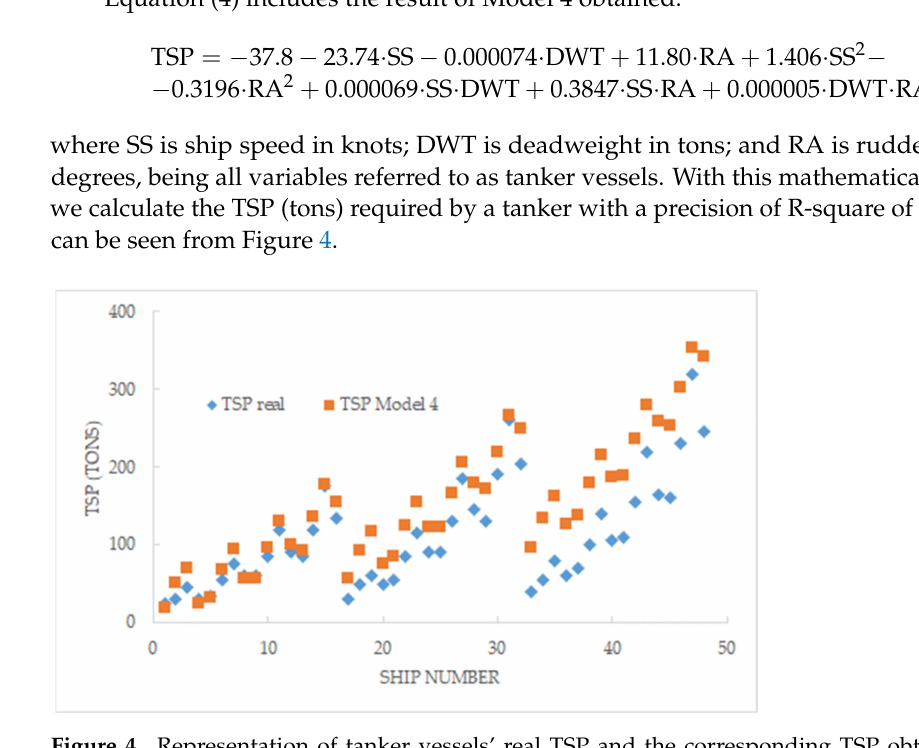
Figure 4. Representation of tanker vessels’ real TSP and the corresponding TSP obtained with Model 4.